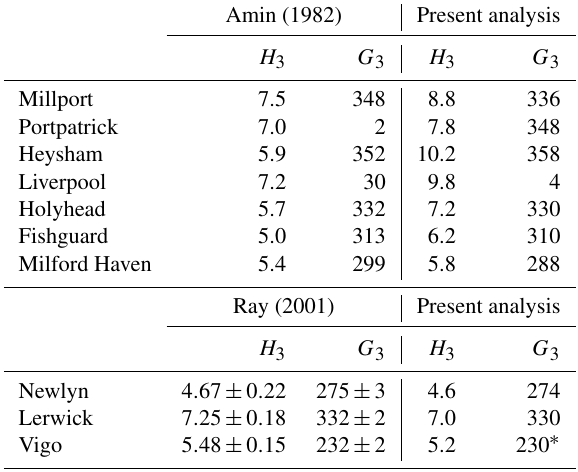
Table 3. Amplitudes (mm) and Greenwich phase lags ( ◦ ) for M1 as reported in Amin (1982) and Ray (2001) and the corresponding values in the present analysis.